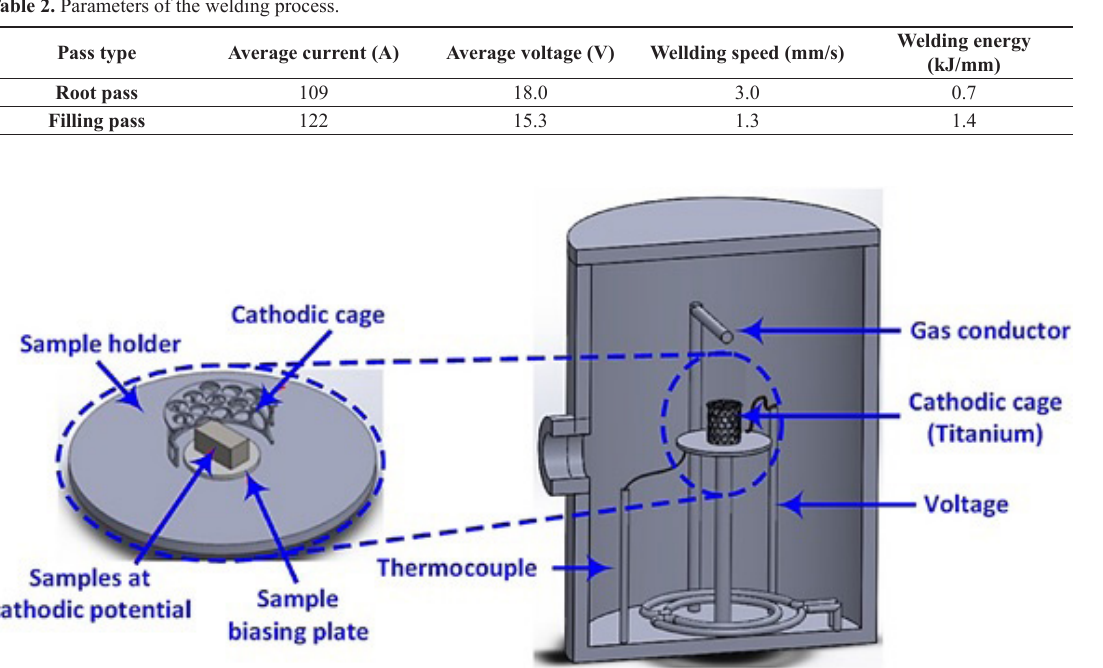
Figure 1. Schematic representation of the cathodic cage plasma deposition system, as reported by Libório et al. 30 .